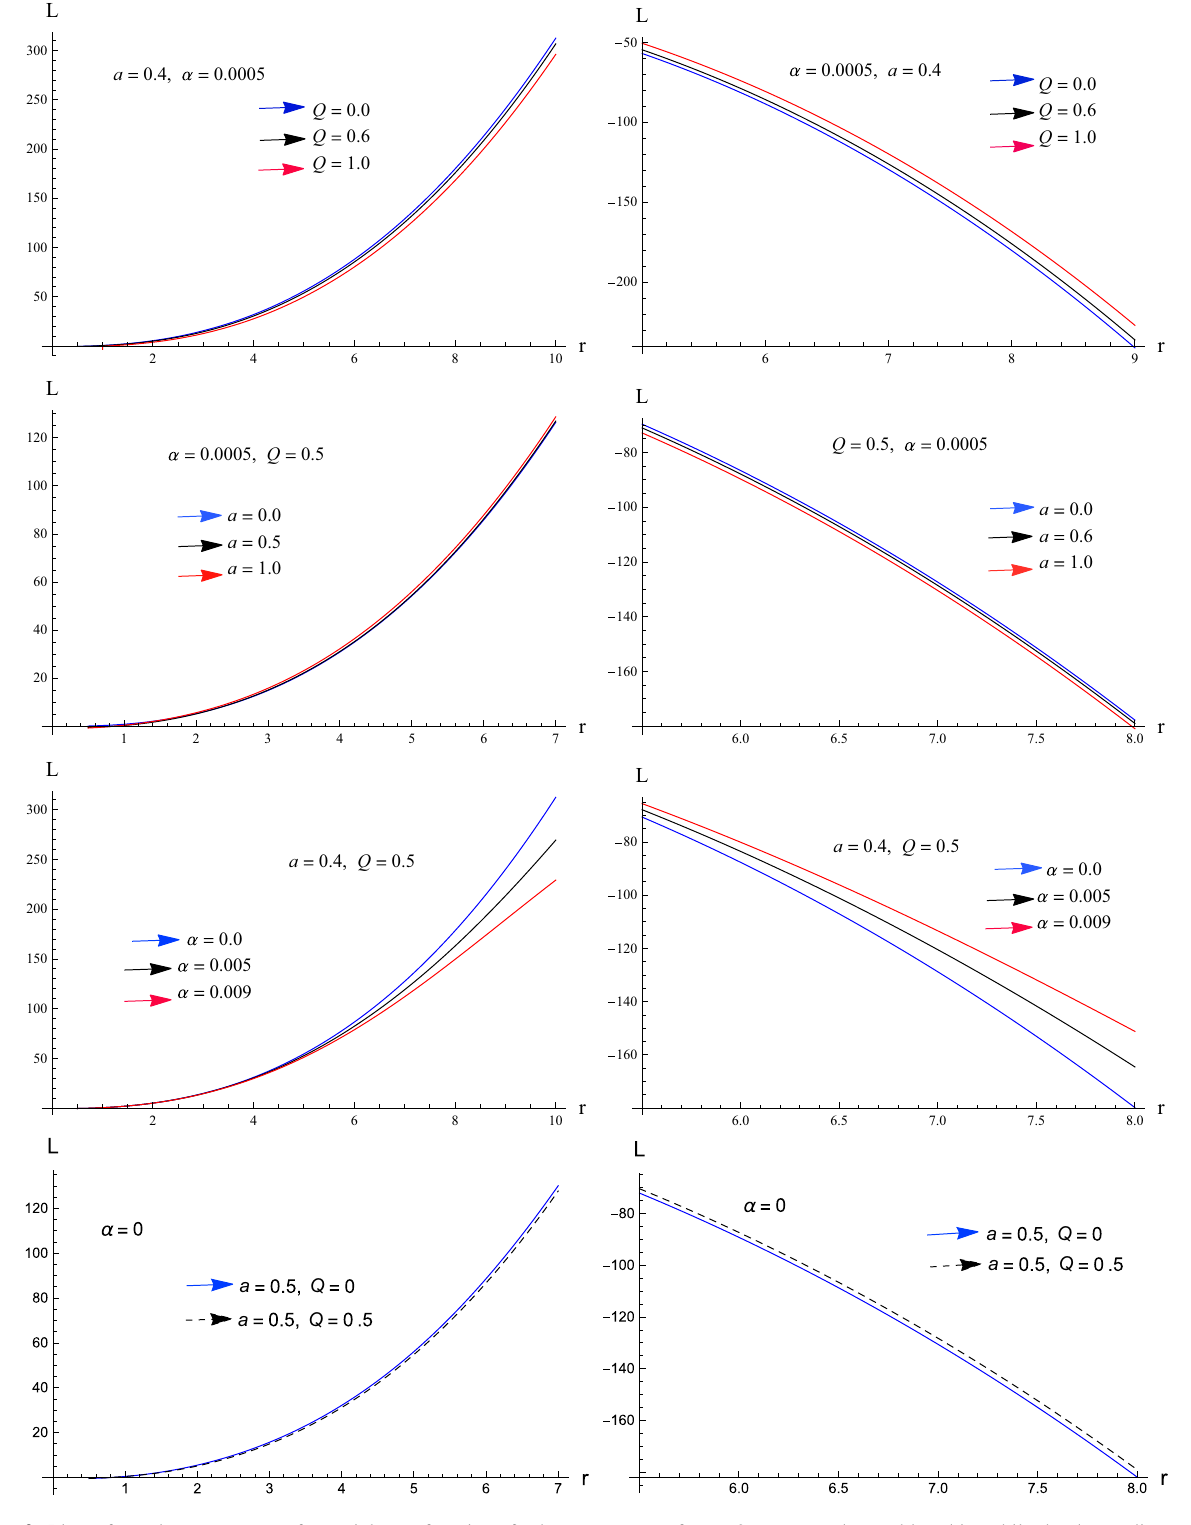
parts of L < 0 correspond to stable orbits while the descending parts of L > 0 and ascending parts of L < 0 lead to unstable